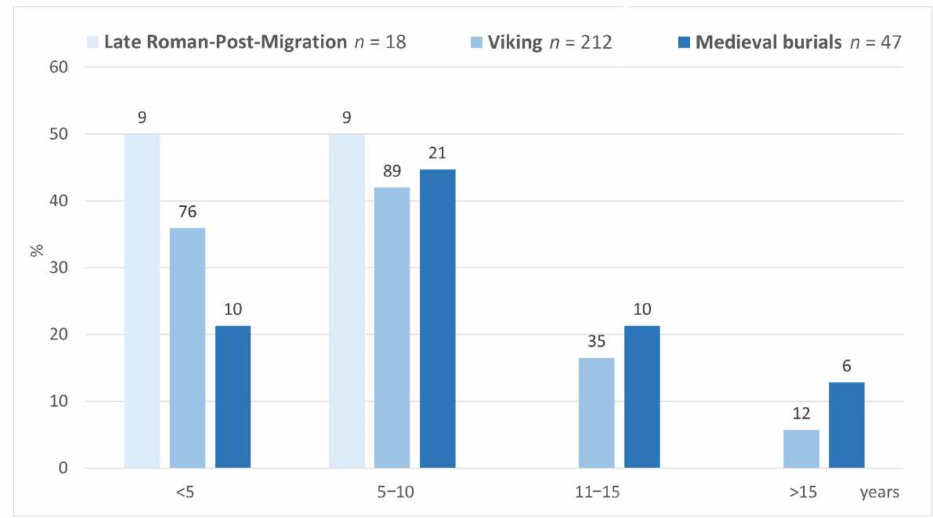
Figure 10. The age distribution of individuals. Above the columns is given number of individuals.